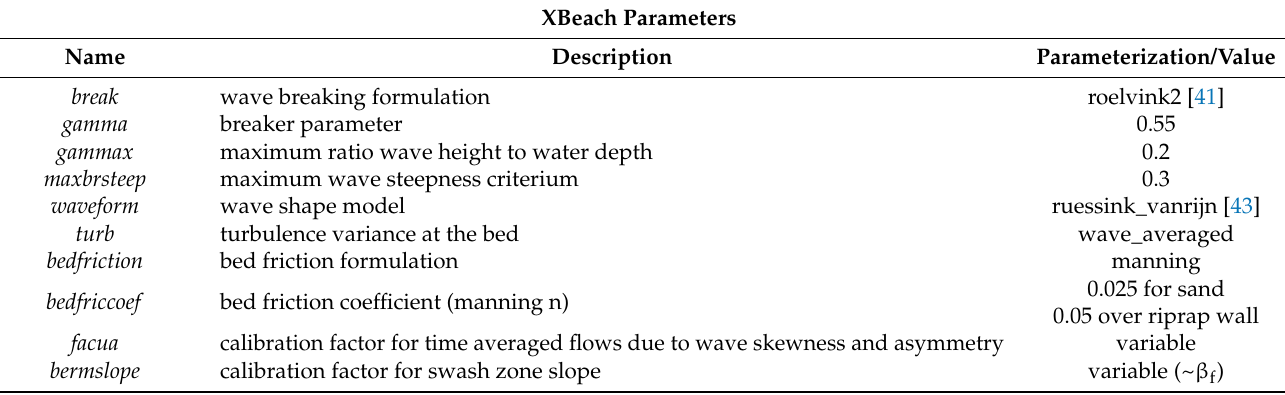
Table 2. Simulation/calibration parameters. XBeach